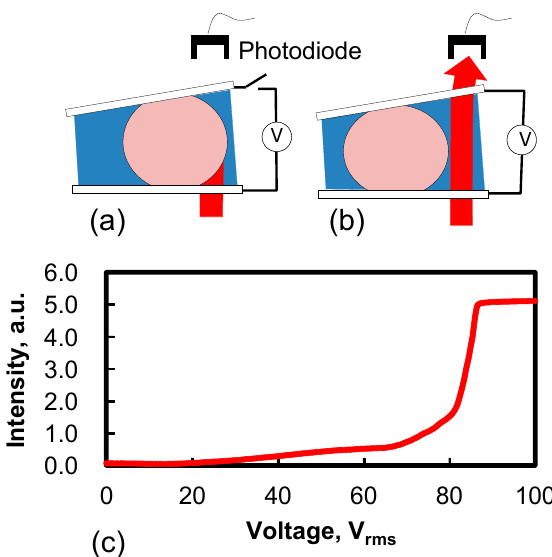
Figure 7. Method to measure the electro-optical property of the liquid cell. ( a ) Blocking the probing beam, ( b ) uncovering the beam, and ( c ) dependent of light transmission on the driving voltage. The time of the voltage applying on the droplet is 17 s.